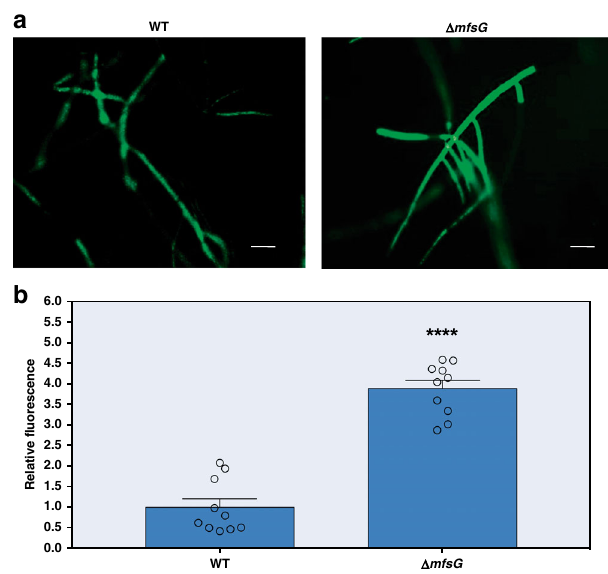
Fig. 3 mfsG confers ITC ef fl ux in B. cinerea . a Fluorescence accumulation in Δ mfsG relative to the wild type (WT) 4 days after exposure to 25 mg ml − 1 FITC. b Quanti fi cation of fl uorescence accumulation in Δ mfsG relative to WT hyphae. Data are displayed as mean values (± SE) of relative fl uorescence. Asterisk denotes signi fi cant difference by Student ’ s t test ( P < 0.001), n = 10. Scale bars are 20 μ m. Source data are provided as